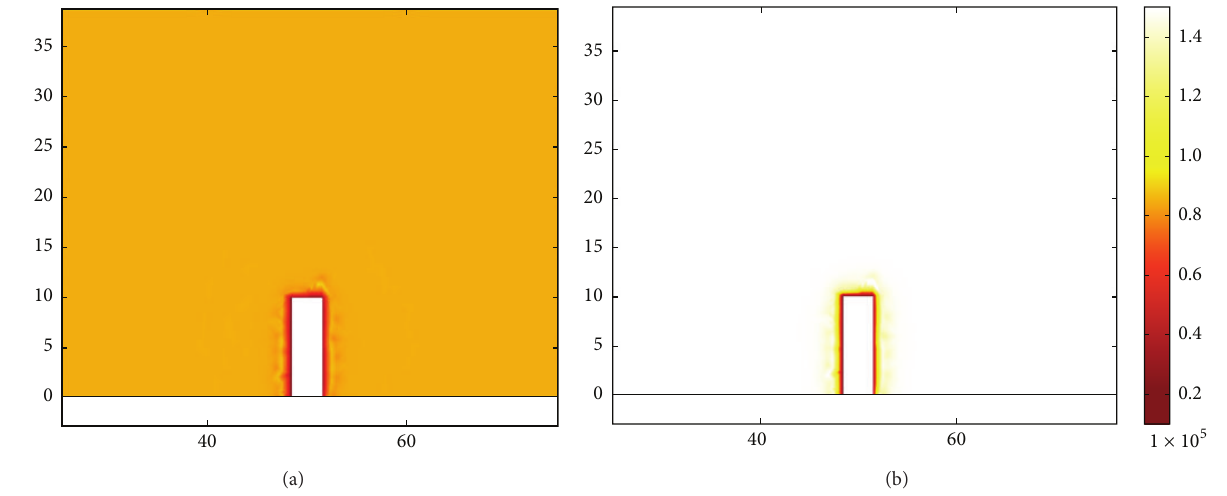
Figure 2: Distribution of coal gas pressure in fractures surrounding the roadway.